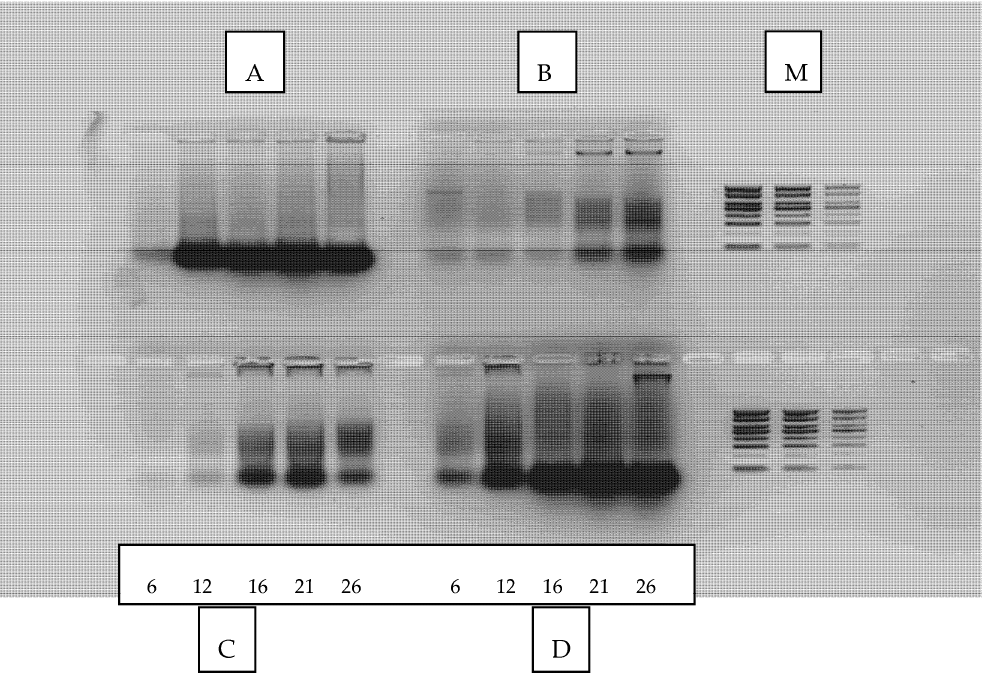
Figure 2. Representative electrophoresis in 2% agarose gel of crude RNA released from lysed fungal cells of (A) A. bisporus , (B) A. subrufescens , (C) P. eryngii , (D) P. ostreatus. (M) refers to DNA marker (1kb).